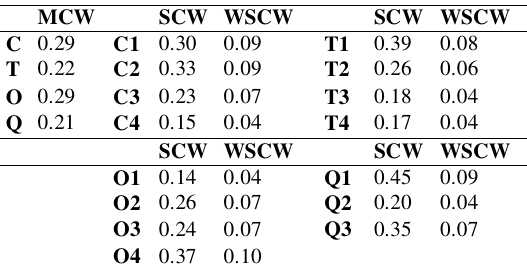
Table 6. Main criteria weights (MCW), sub-criteria weights (SCW) and weighted sub-criteria weights (WSCW)